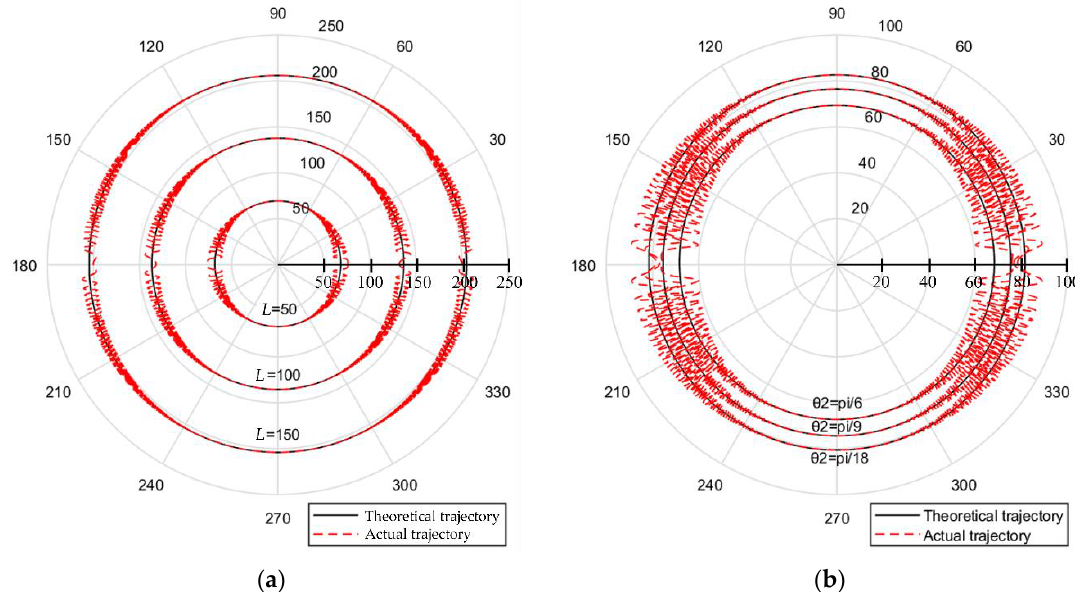
Figure 6. Simulation results of the influence of the periodic errors on the circular motion trajectory of machine tool. ( a ) The result under different bar lengths. ( b ) The result under different pose angles.